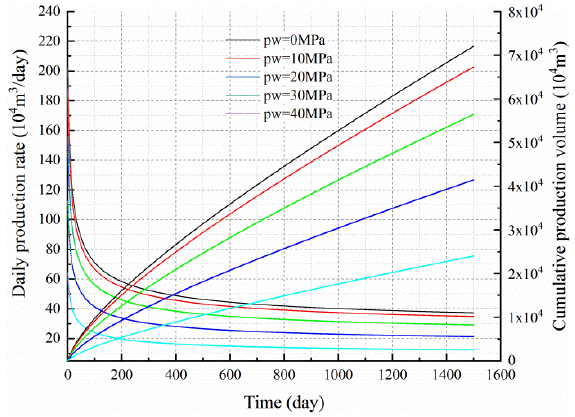
Figure 16. The e ff ect of di ff erent WBHPs on Figure 16. The effect of different WBHPs on productivity.